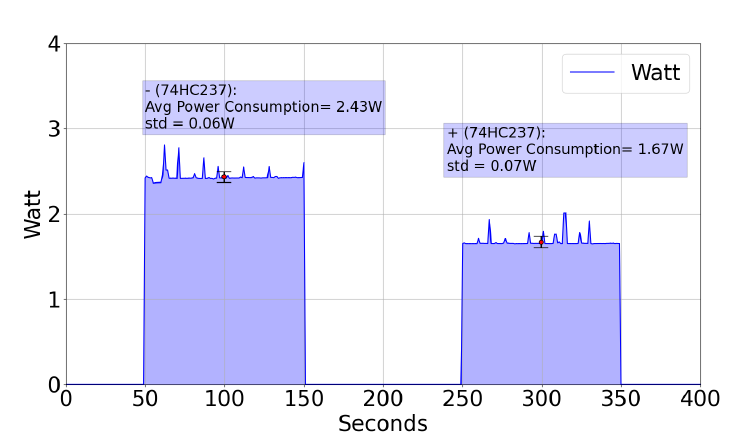
Figure 16. WaterMon Submission Time.